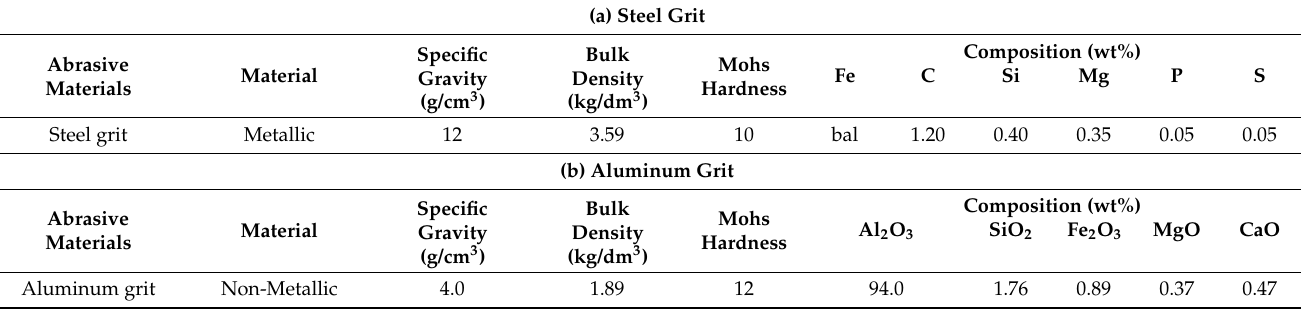
Table 2. Chemical composition of abrasive